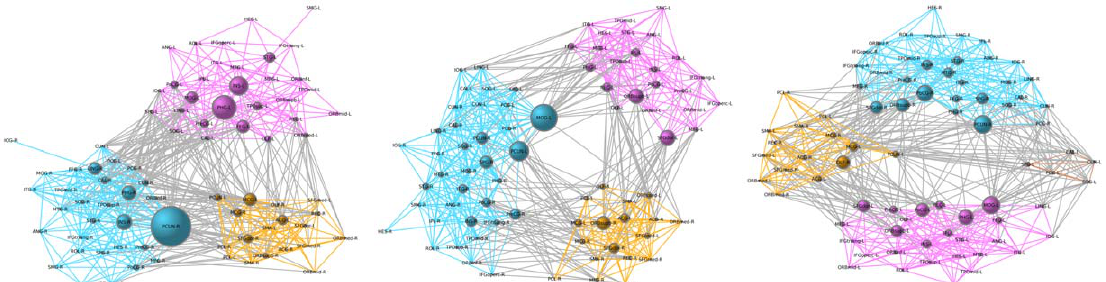
Figure 8. Network Communities. The spring-embedding visualization of networks is implemented with Kamada-Kawai layout algorithm using the Pajek [57] software package (pajek.imfm.si/doku.php). The nodes and intra-modular connections are colored-coded by the communities detected by the algorithm described in [16], while inter-modular connections are colored-coded with light-gray. The sizes of the vertices are weighted by the (logarithmically scaled) node betweenness [29]. Descriptions of the abbreviated region labels can be found in Table 1. See Table 3 for the constituent regions in each community.